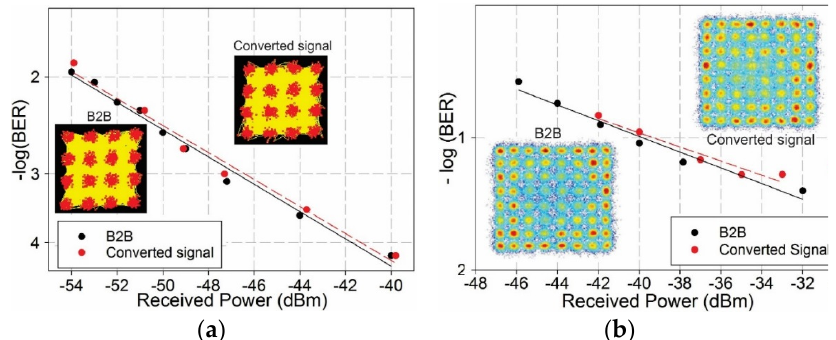
Figure 10. BER curves and constellation diagrams for the: 16-QAM (Quadrature Amplitude Modulation) ( a ); and 64-QAM ( b ), before and after the wavelength conversion process.